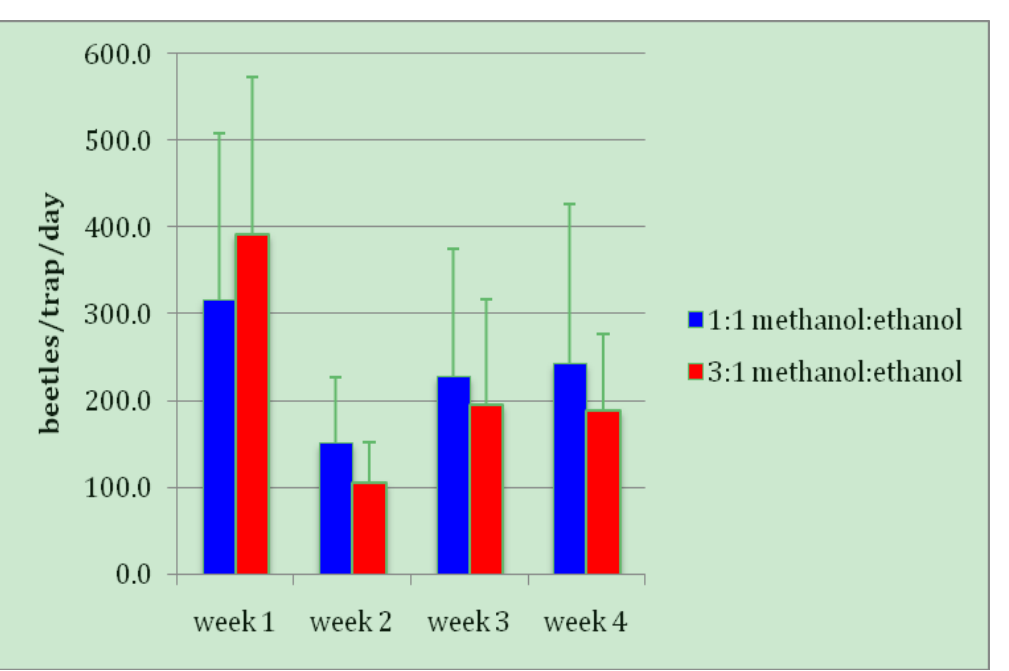
Figure 2. Mean number of adult coffee berry borers captured per trap per day in Brocap traps containing two different ratios of methanol: ethanol.